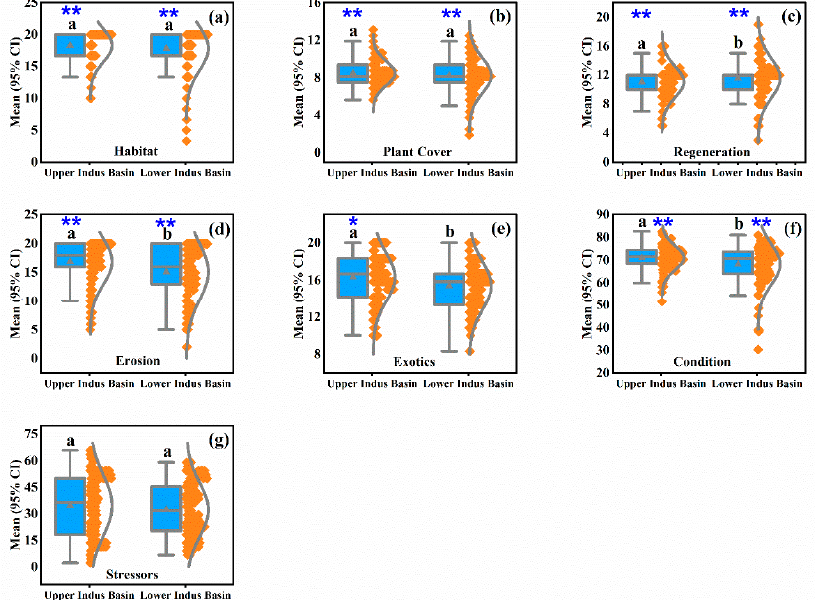
Figure 3. Box and whisker plots for riparian health indicators ( a – f ) and stressors ( g ) measured in the upper and lower Indus basin riparian zones of the Indus River in Pakistan. The y-axis denotes the mean scores with 95% confidence interval (CI). The silver horizontal line represents the median, and the silver triangle sign symbolizes the mean. The boxes represent the 25th–75th percentiles, and the whiskers outside the boxes represent the 10th–90th percentiles. The silver curve symbolizes the shape of data distribution, whereas the orange rhombus represents data distribution. Note: significance is at p < 0.01 (**) or p < 0.05 (*) of the Kruskal–Wallis tests. Moreover, pairwise comparisons between the upper and lower Indus basins are marked with non-identical lowercase letters (a,b) using Dunn-Bonferroni post hoc tests.